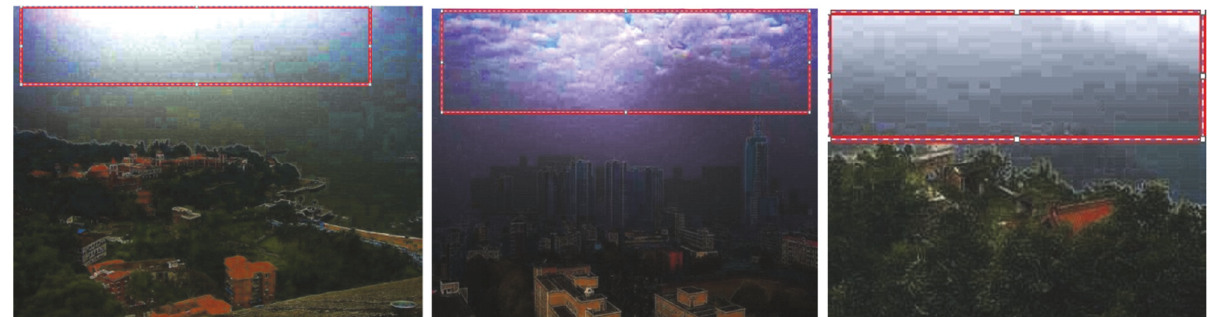
Figure 4: Clearness images restored from images with light color